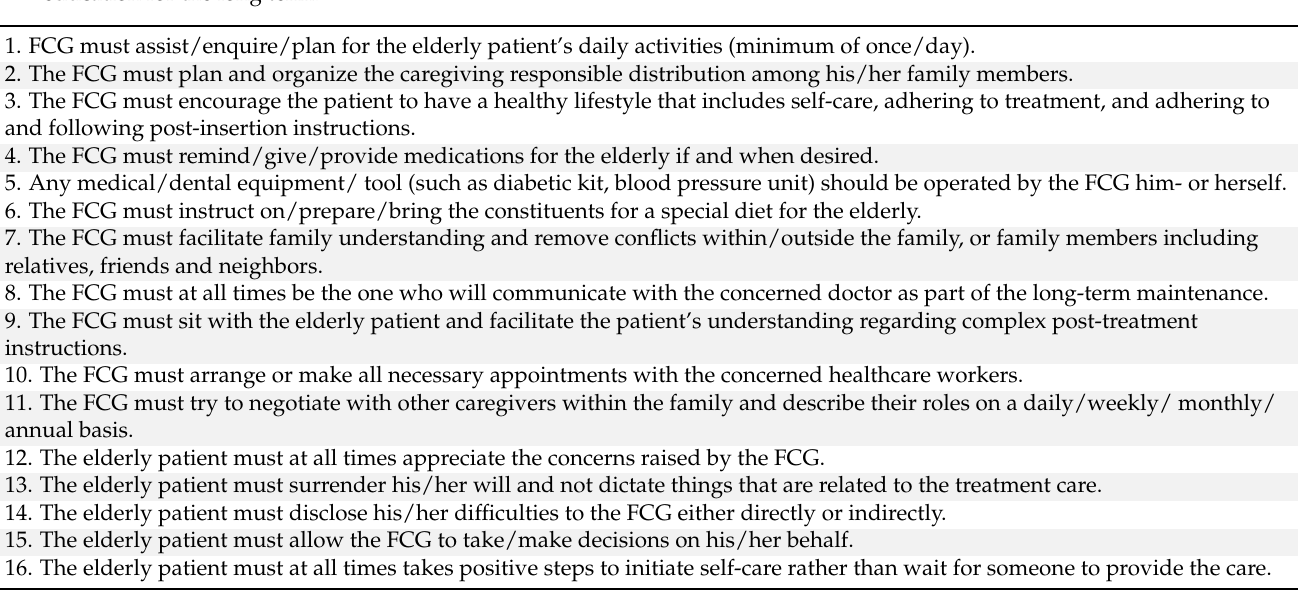
Table 4. Outline of home care instructions (for elderly patient and FCG) to sustain the influence of psychotherapeutic education for the long